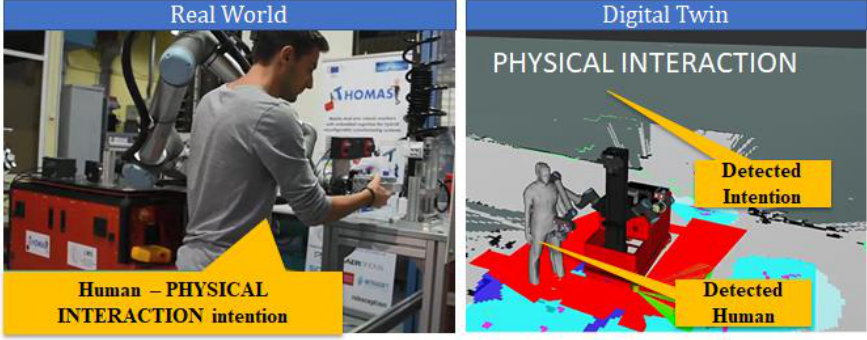
Figure 14. Human PHYSICAL INTERACTION intention detected. Table 3. Comparison of the two systems—responsiveness to